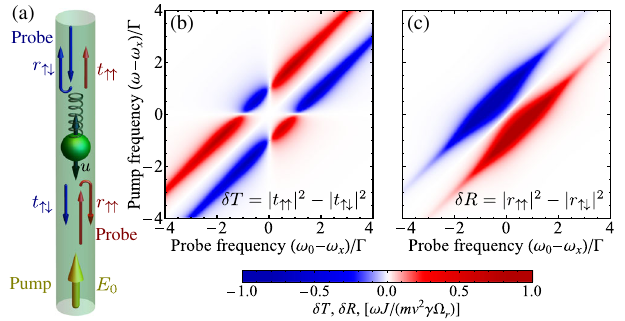
FIG. 7. (a) A sketch of an optomechanical system consisting of a waveguide and a small particle that can oscillate in space along its axis. Color plots of the optomechanically induced probe light (b) nonreciprocal transmission and (c) asymmetrical reflection as a function of pump and probe light frequencies. Calculation is made for a resonant particle with the reflection coefficient